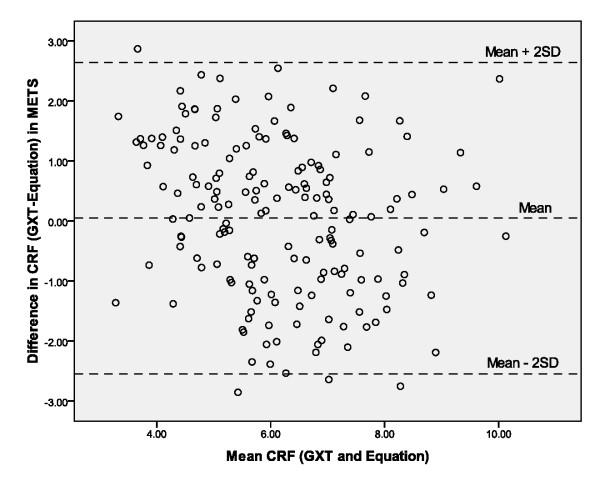
Bland-Altman plot.